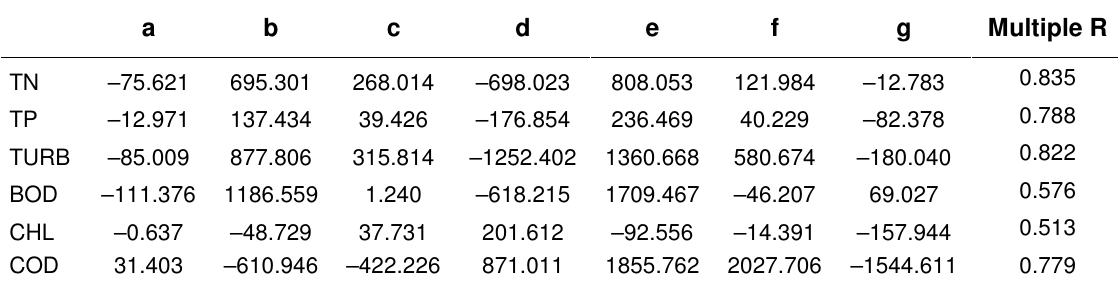
Coefficients and Multiple R Values Determined for Selected WQ Parameters through Multiple Regression